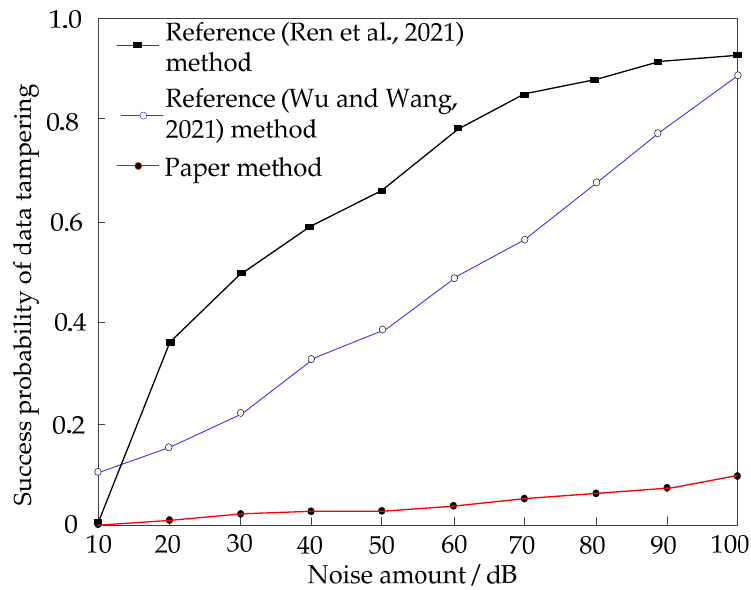
Figure 8. Success probability of data tampering by different methods [6, 7].